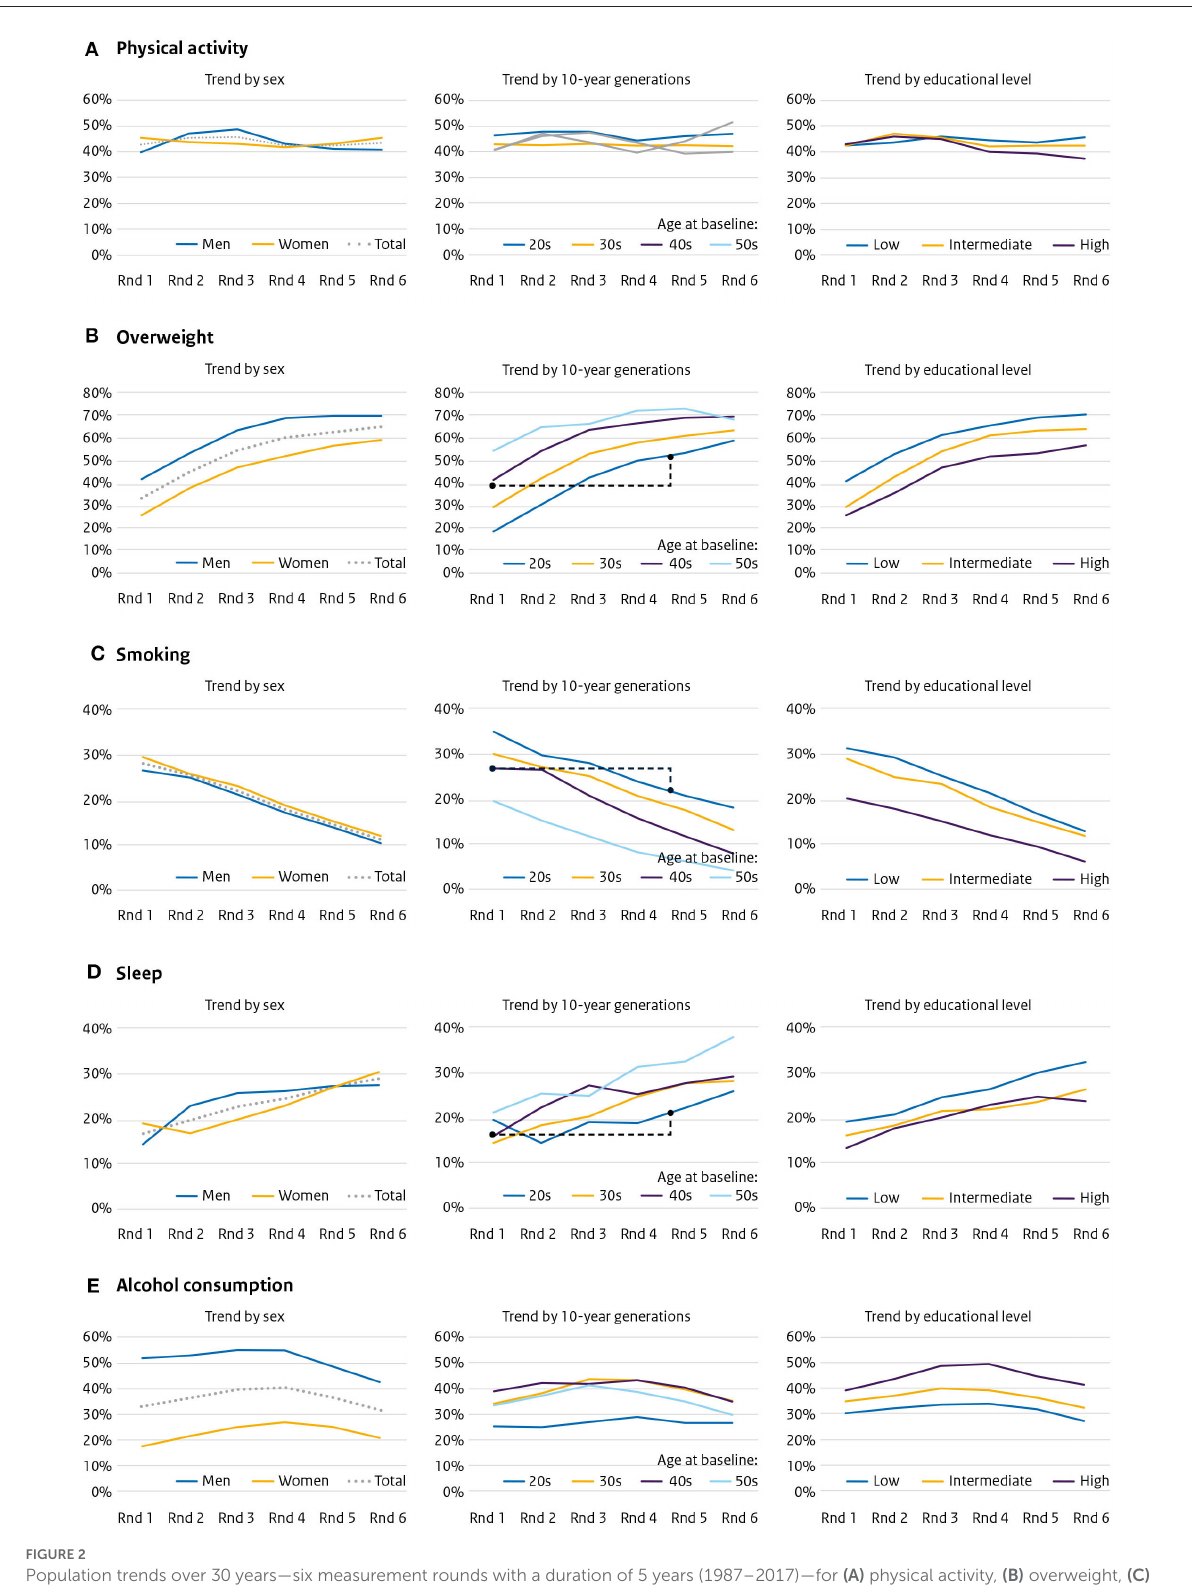
FIGURE2 Population trends over 30 years—six measurement rounds with a duration of 5 years (1987–2017)—for (A) physical activity, (B) overweight, (C) smoking, (D) sleep, and (E) alcohol consumption, by sex, 10-year generation and educational